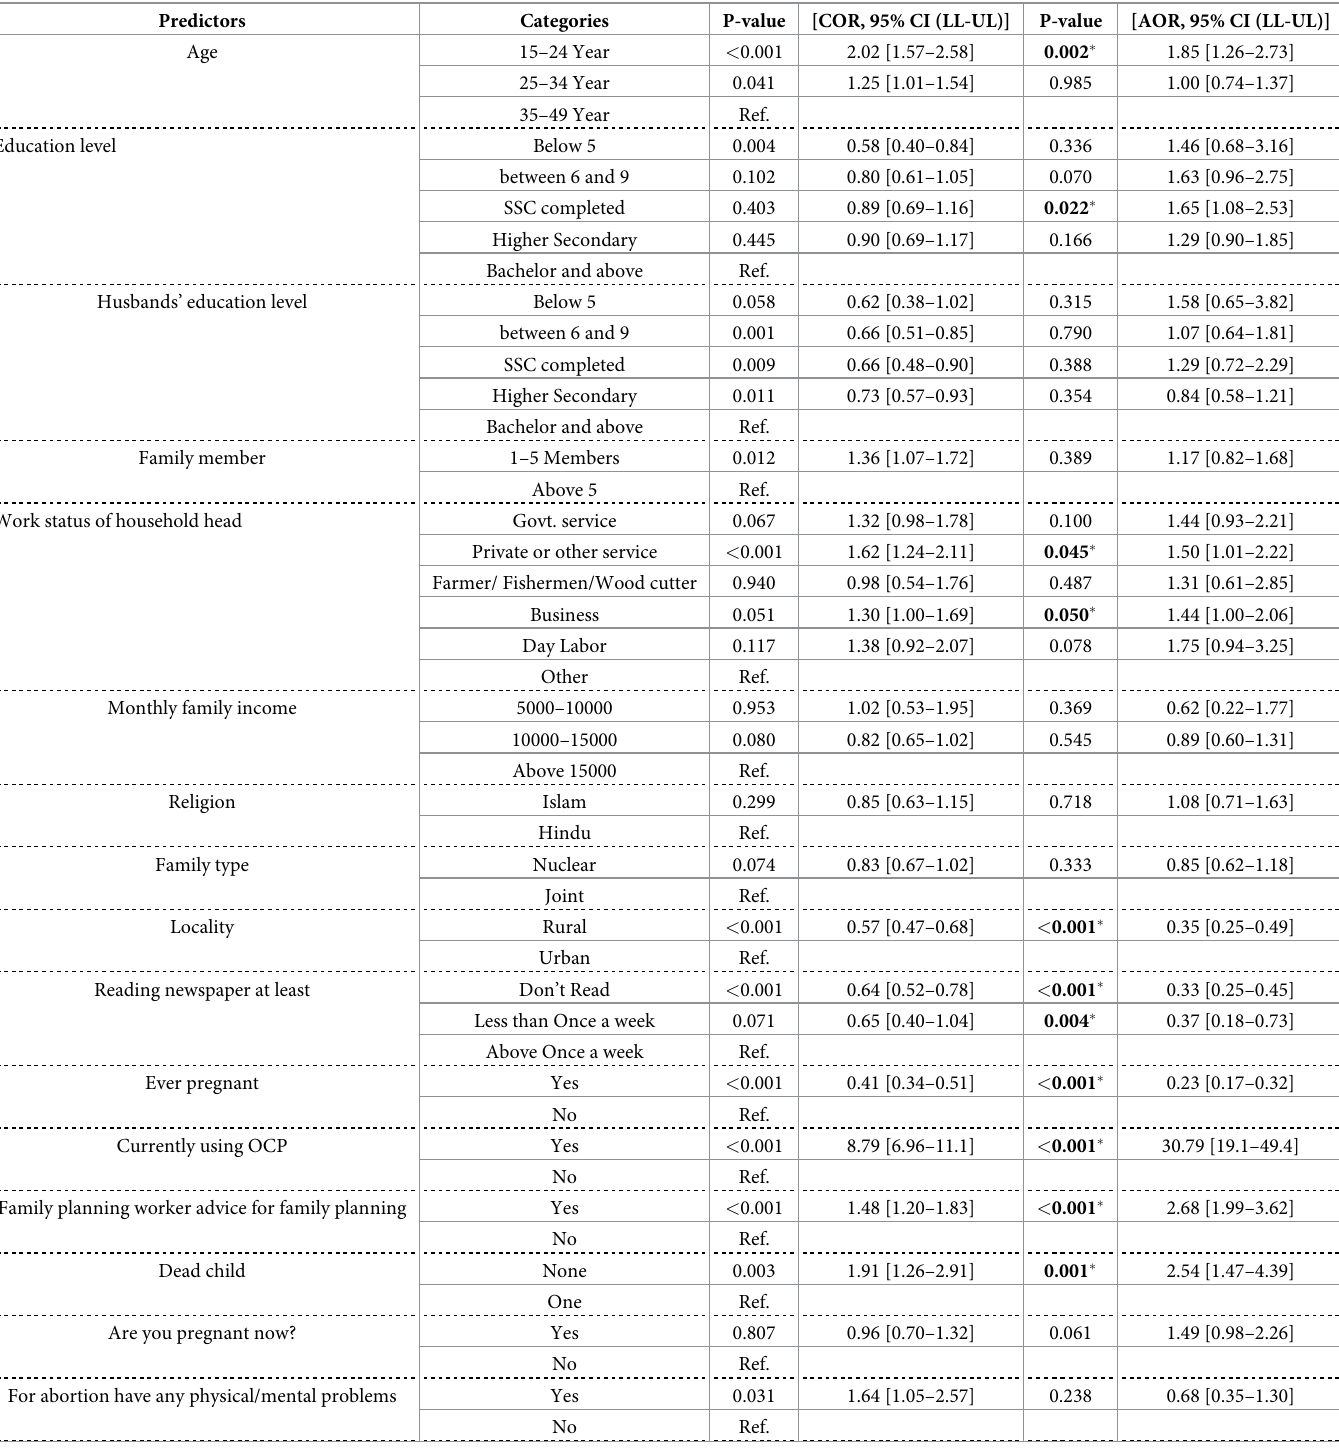
Table 2. Regression model for the factors affecting currently used FP during COVID 19